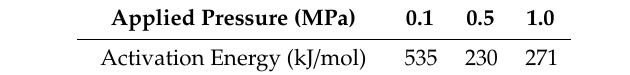
Condition of oxidation reactions of mesophase pitch under various applied pressure; heating rates: Table 1. Activation energies on the oxidation reactions of mesophase pitch under various applied pressures.